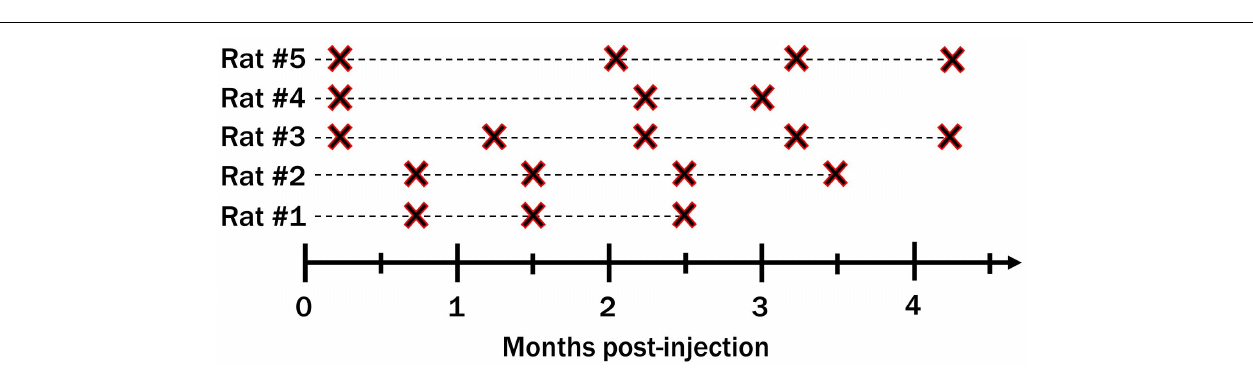
FIGURE 3 | Timeline of MRI scans taken for all five